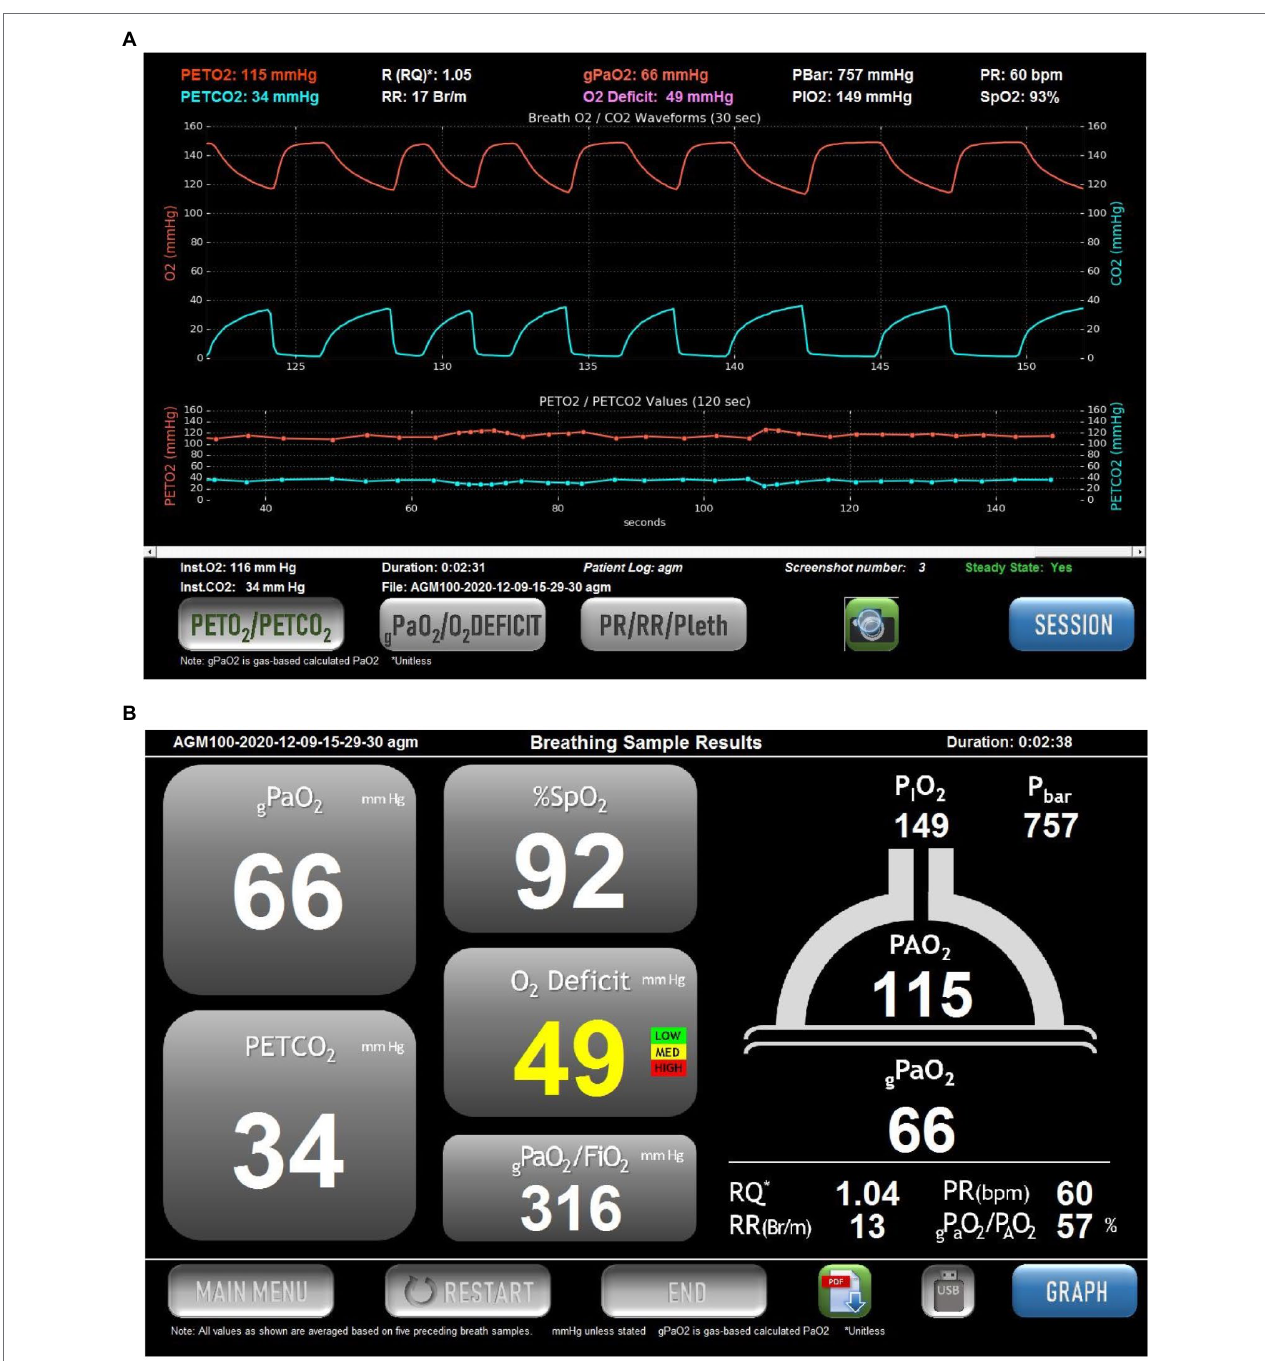
FIGURE 1 | Example of the screens displayed in the commercial version of the Alveolar Gas Meter (AGM100 TM , MediPines Corp, Costa Mesa, CA). Data are taken from a spontaneously breathing patient suffering from COVID-19. (A) Continuous records of PO 2 (red) and PCO 2 (blue) over a 30-s period of quiet breathing (upper traces). Note that in this patient there is a steep alveolar plateau for O 2 and CO 2 , indicative of marked heterogeneity in the lung. Below these are plots of end-tidal PO 2 (red) and PCO 2 (blue) over the preceding 150 s. The lower traces allow an assessment of whether the patient is in a steady state. This is also indicated by the Steady State indicator in the lower right of the screen. At the top of the screen are numerical values for the end-tidal partial presses of O 2 and CO 2 , the respiratory quotient (RQ), respiratory rate (RR), barometric pressure (PBar), inspired PO 2 (PIO 2 ), pulse rate (PR) and arterial oxygen saturation via pulse oximetry (SpO 2 ). In the center at the top is the calculated arterial PO 2 (termed gPaO 2 , red text), and the O 2 Deficit (the difference between end-tidal PO 2 and calculated arterial PO 2 ). (B) A screen summarizing the data from (A) without the graphical displays. The cartoon of the lung on the right shows the measured end-tidal PO 2 (115 mmHg in this example), and the calculated arterial PO 2 (gPaO 2 , 66 mmHg in this example), which together result in the oxygen deficit in traffic-light color-coded text (49 mmHg in this example). The operator may toggle between this screen and that in (A) as